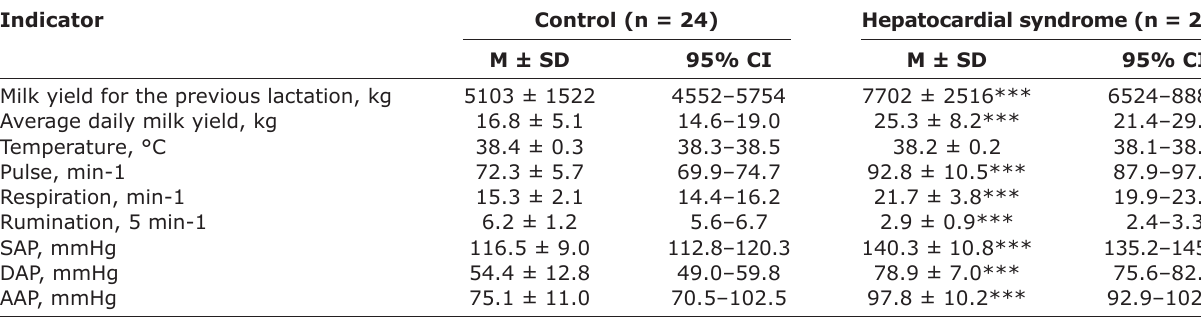
Table-1: Clinical indicators for hepatocardial syndrome in dairy cows. Indicator